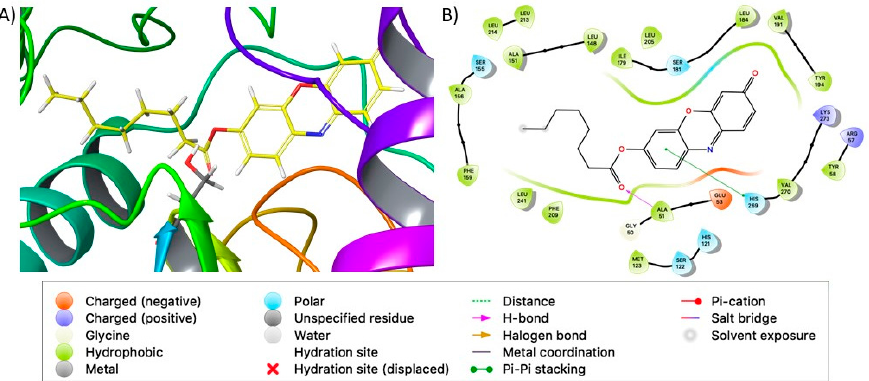
Figure 5. ( A ) Docking poses of compound 1c into the MAGL binding site. MAGL is shown in ribbon representation; tested compound and Ser122 are shown in stick representation and hydrogens are hidden. ( B ) Ligand interaction diagram of compound 1c into the MAGL binding site.